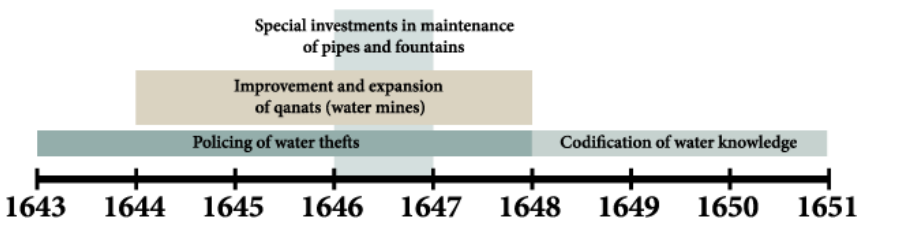
Figure 8. Strategies of institutional response to drought (1643–1650). Source: the present authors.